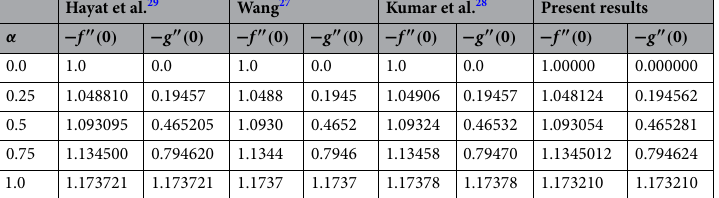
Hayat et al. 29 Wang 27 Kumar et al. 28 Present results